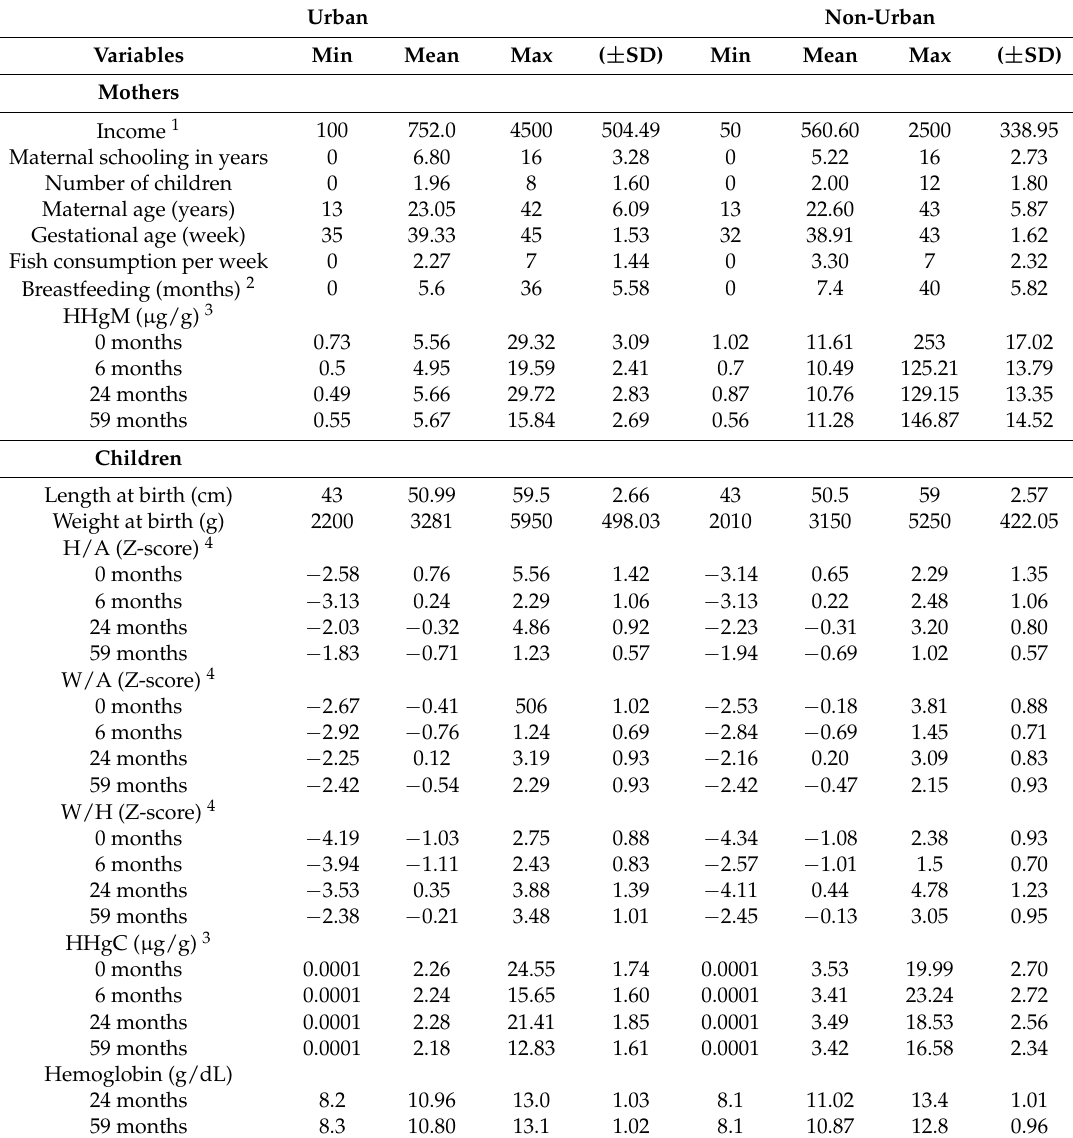
Table 1. Characteristics of the 1343 pairs of mothers and children comprising the 5-year Rond ô nia study population. Urban